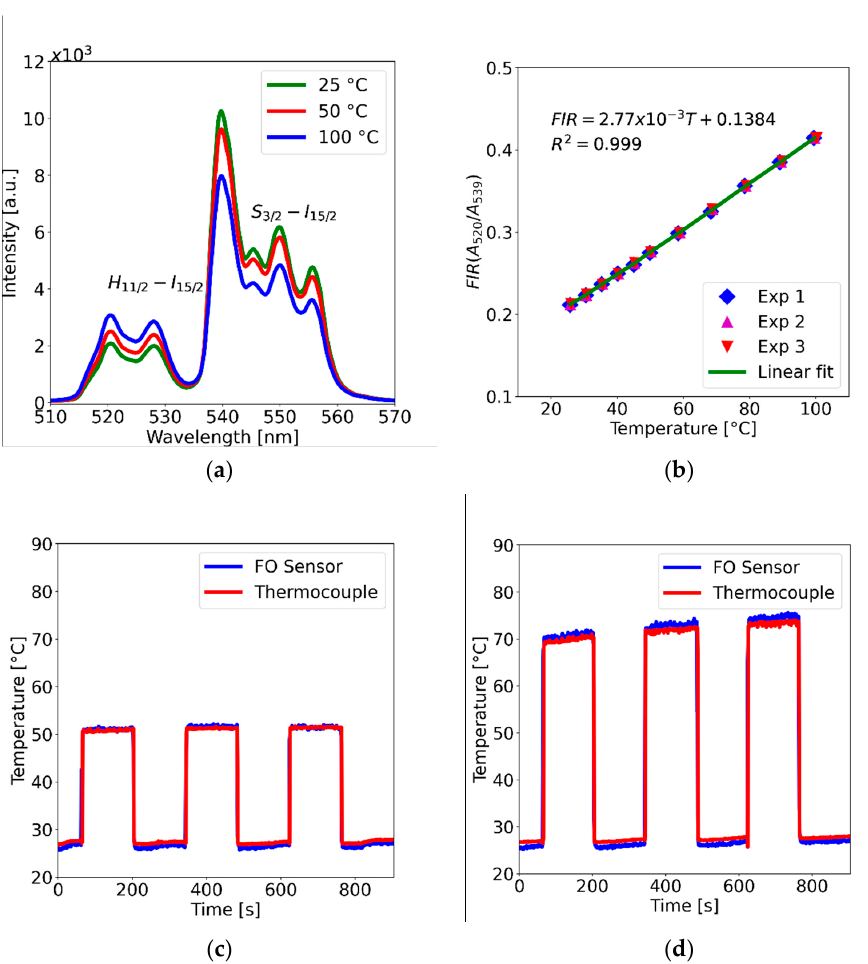
Figure 13. ( a ) Fluorescence spectra obtained from the PDMS-YbEr fiber tip (140 mW optical power); the bands labelled H 11/2 – I 15/2 and S 3/2 – I 15/2 are thermally coupled, and their ratio is used to obtain the temperature. ( b ) Fluorescence intensity ratio (FIR) as a function of temperature. ( c , d ) Readout of the fluorescence temperature sensor compared with a thermocouple sensor.